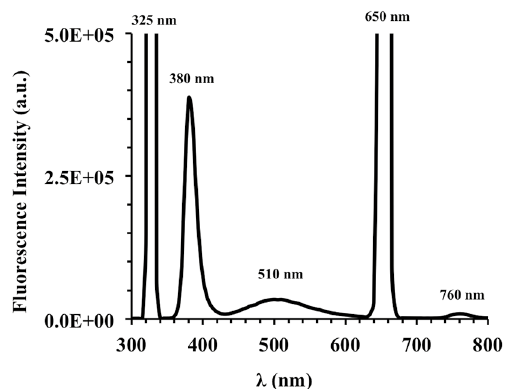
Figure 7. Fluorescence spectrum of sample Z obtained with excitation of 325 nm. Emission at 380 nm closely resembles with the computed values of BG obtained with the application of methods M1, M2 and